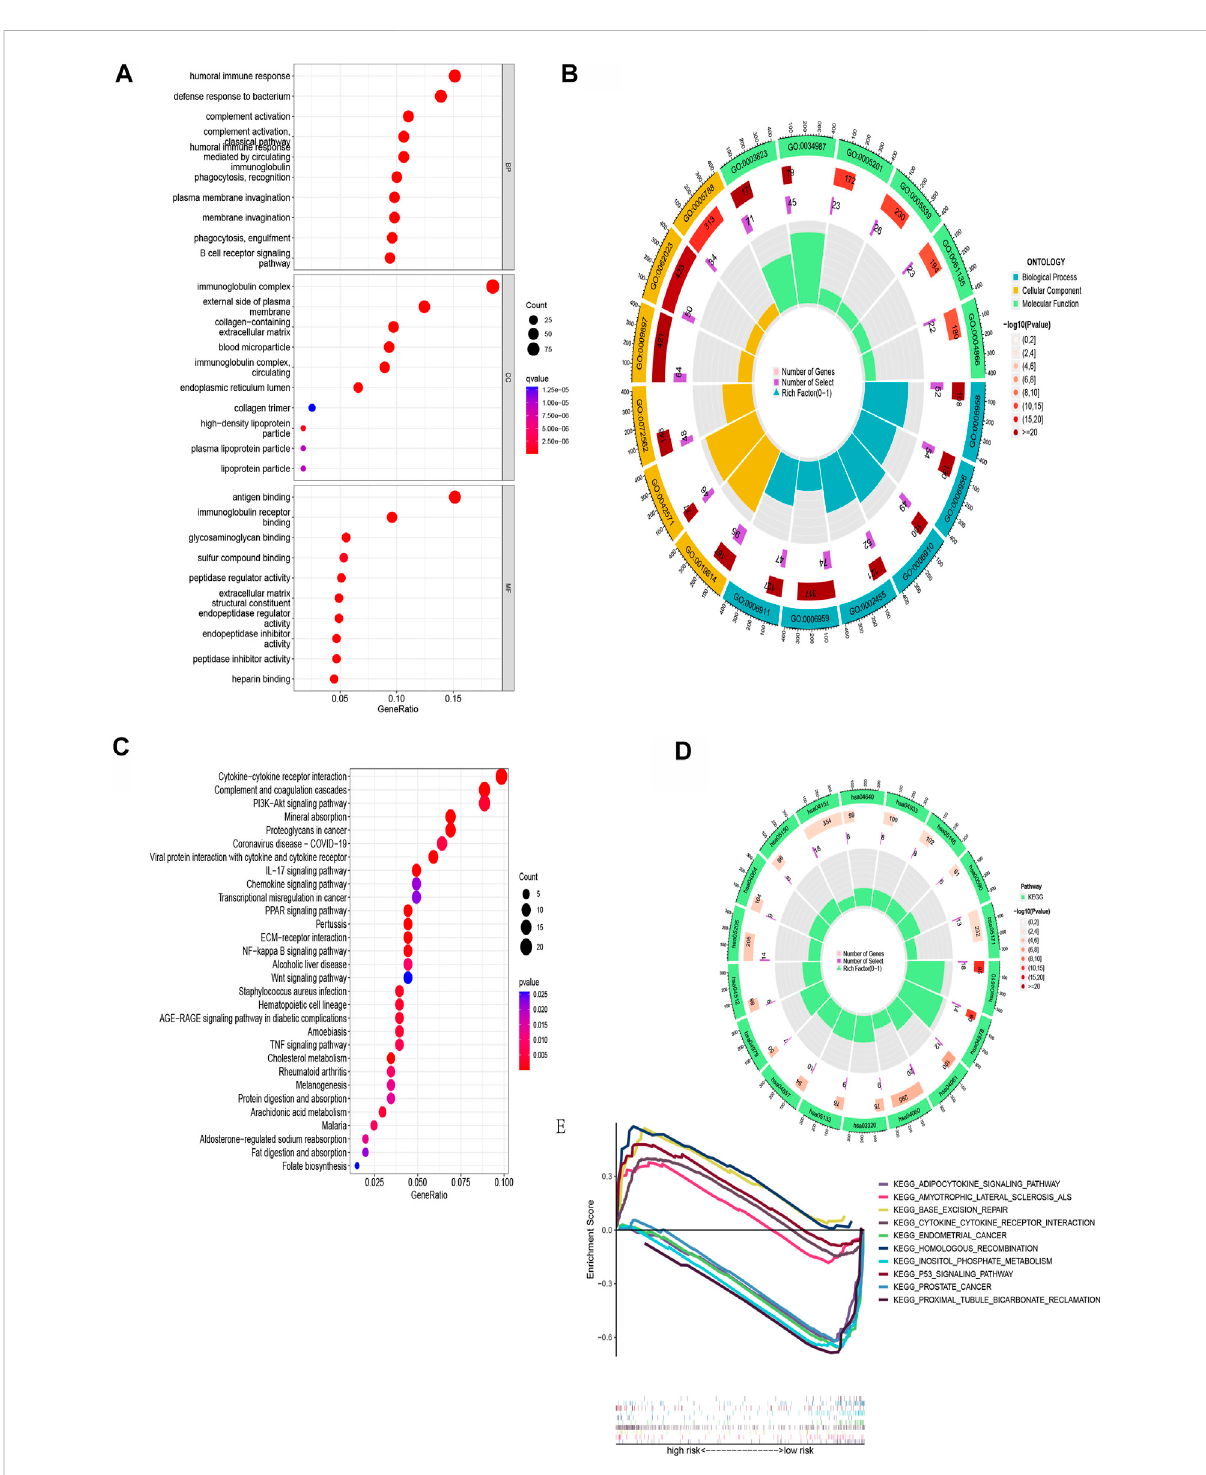
FIGURE 7 Functional enrichment for differentially expressed BMRGs between the two groups. (A) The top 30 signi fi cant terms of GO functional enrichment. (B) The circle diagram enriched in the GO analysis. (C) KEGG functional enrichment ’ s top 30 signi fi cant terms. (D) The circle diagram enriched in the KEGG analysis. (E) GSEA analysis of the top fi ve enrichment pathways in the low- and high-risk groups,